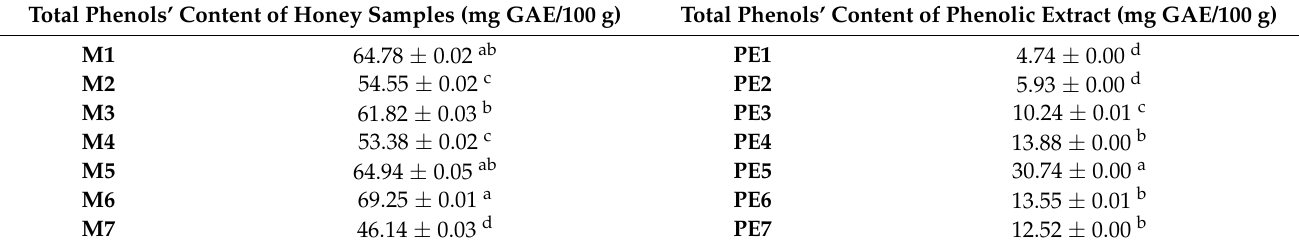
Table 5. Total phenols’ content of Euphorbia honey samples (M1, M2, M3, M4, M5, M6, M7) and their phenolic extracts (PE1, PE2, PE3, PE4, PE5, PE6, PE7). The results of M2 and M3 samples were previously published [13] Reproduced with permission from Oumaima Boutoub et al., Antioxidant activity and enzyme inhibitory potential of Euphorbia resinifera and E. officinarum honeys from Morocco and plant aqueous extracts; published by Springer Nature, 2020. Total Phenols’ Content of Honey Samples (mg GAE/100 g) Total Phenols’ Content of Phenolic Extract (mg GAE/100